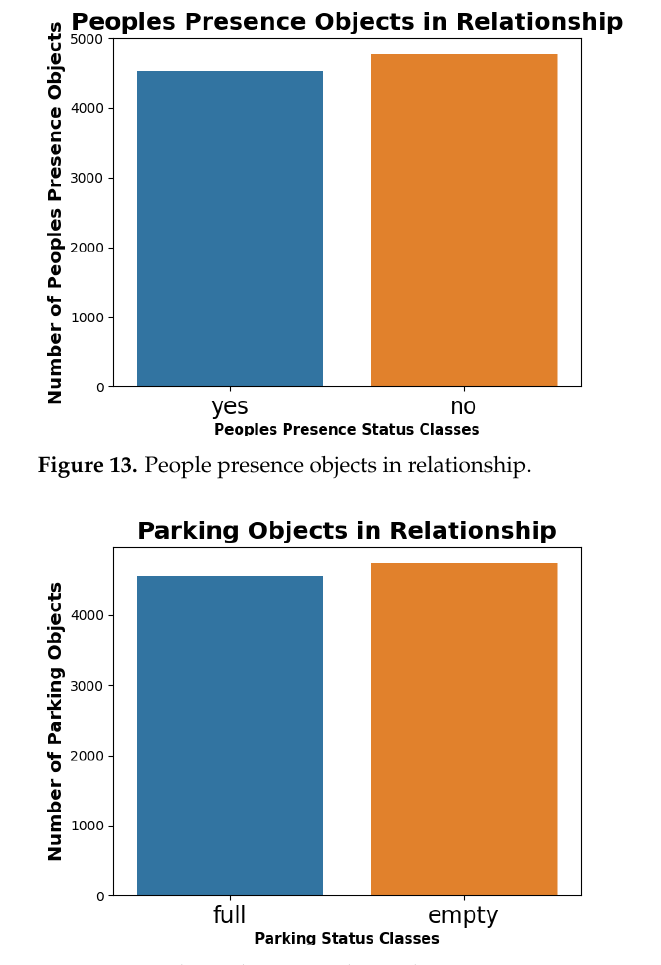
Figure 14. Parking objects in